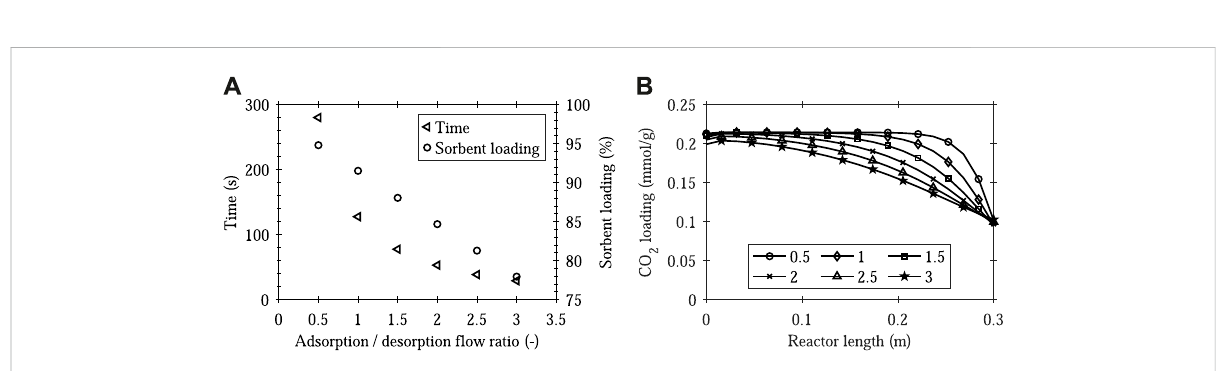
FIGURE 12 MATLABSimulinkresultsforthepilotplantbasecasesimulationwithvariousadsorption-to-desorption fl owratiosinsinglestagecon fi guration. > 0.05intheoutletofthereactionchamber. (A) TimespanofM2,andrelativesorbentloading TheswitchfromM2toM4istriggeredassoonas y {CO 2 } at the end of M2 as a function of the adsorption-to-desorption fl ow ratio (cycle 5 in chamber 1), (B) CO 2 loading at the end of M2 over the reactor length for various adsorption-to-desorption ratios (cycle 5 in chamber